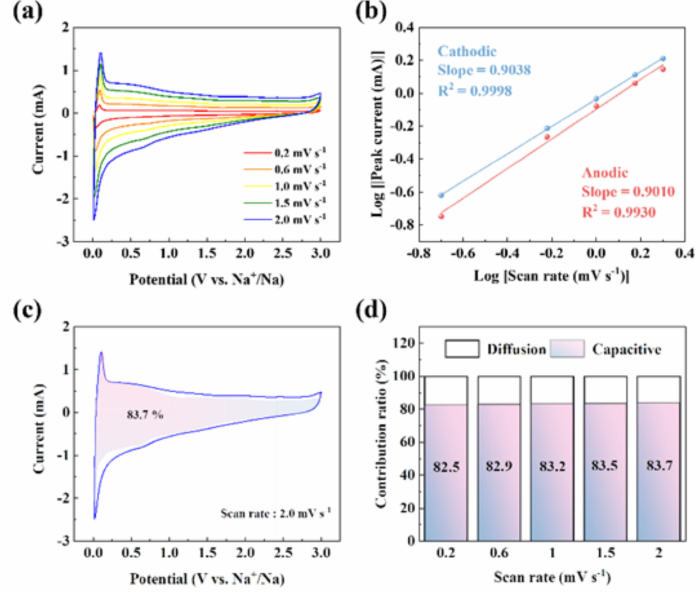
Figure 6. ( a ) CV curves of SP/C at various scan rates from 0.2 to 2.0 mV s − 1 ; ( b ) linear relationship between the logarithms of the current and scan rates of the cathodic and anodic peaks at 0.1 V; ( c ) CV curve and capacitive contribution of SP/C at a scan rate of 2.0 mV s − 1 ; ( d ) corresponding capacitive contribution to the total capacity at different scan